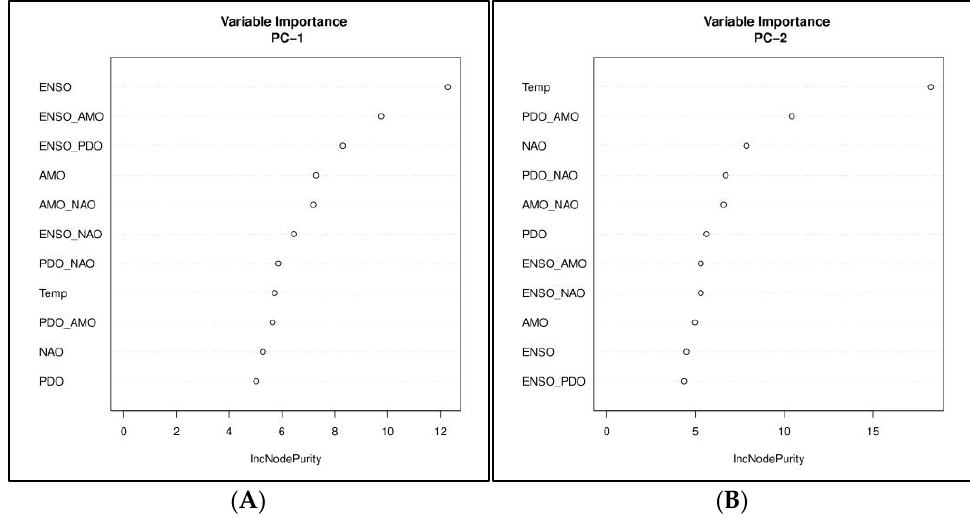
Figure 9. Variable importance plots for random forest models with ( A ) PC-1 and ( B ) PC-2 as the dependent variables. The y-axis denotes all the independent variables used in this study, while the x-axis is a measure mean decrease in Gini or how much the model error increases when a particular variable is randomly permuted or